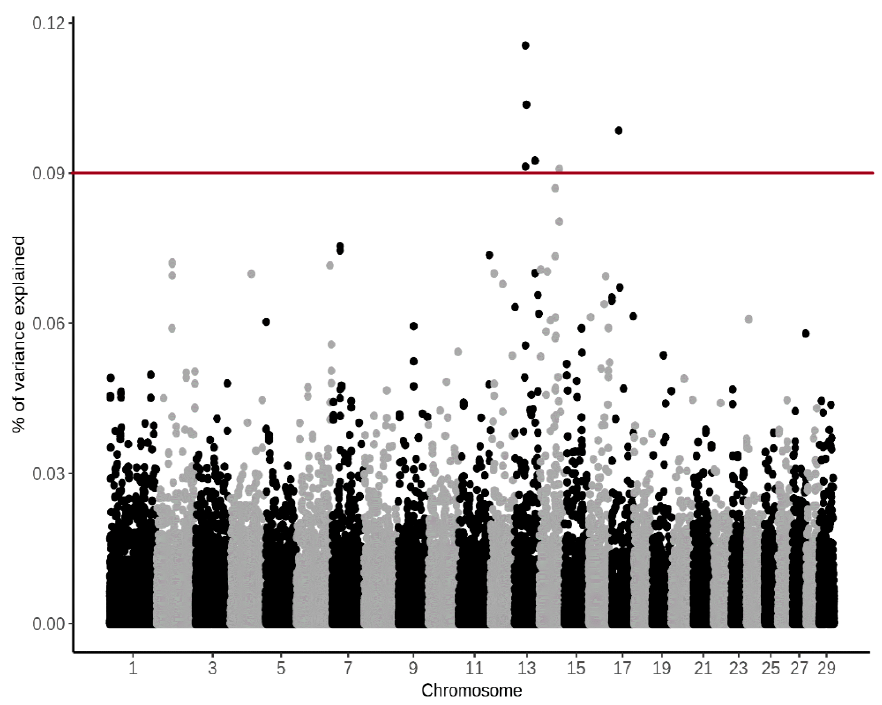
Figure 5. Manhattan plot for % of genetic variance explained by 50-SNP windows for CH4 ppm/d, with an arbitrary threshold line of 0.09%.